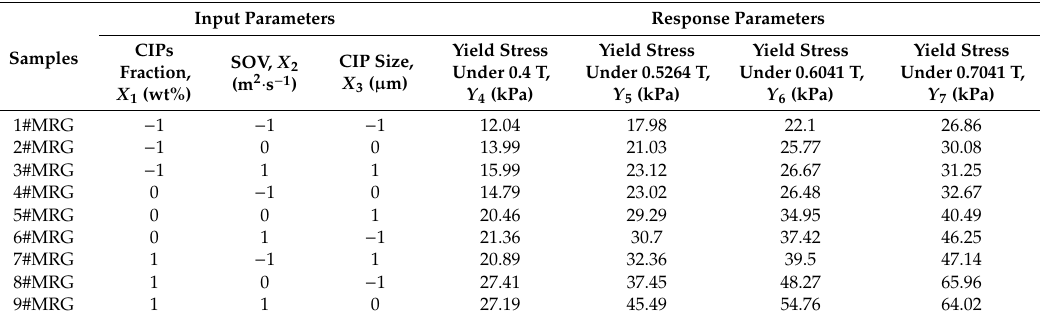
Table 3. Experimental